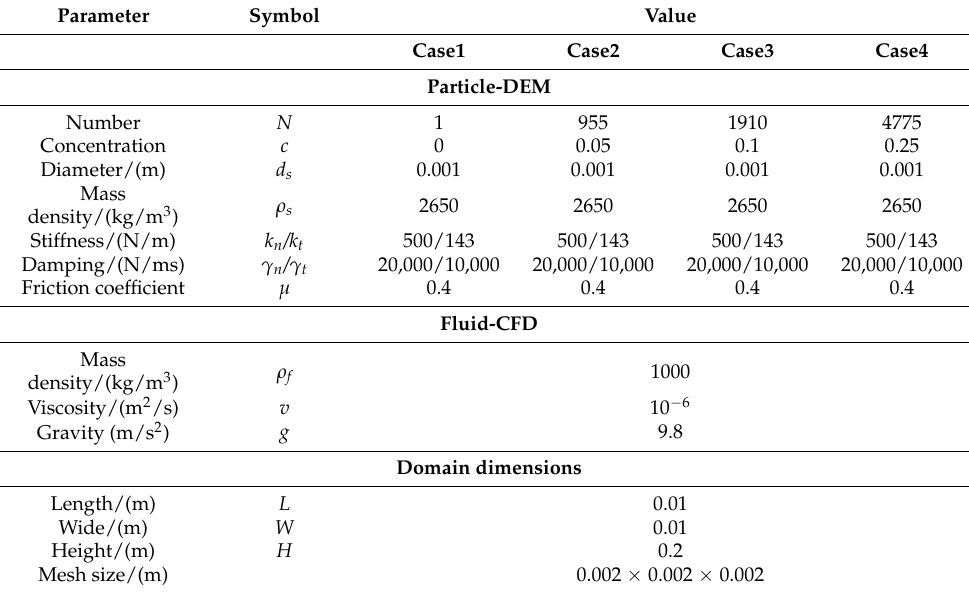
Table 1. Parameters of sedimentation model of multiple particles.